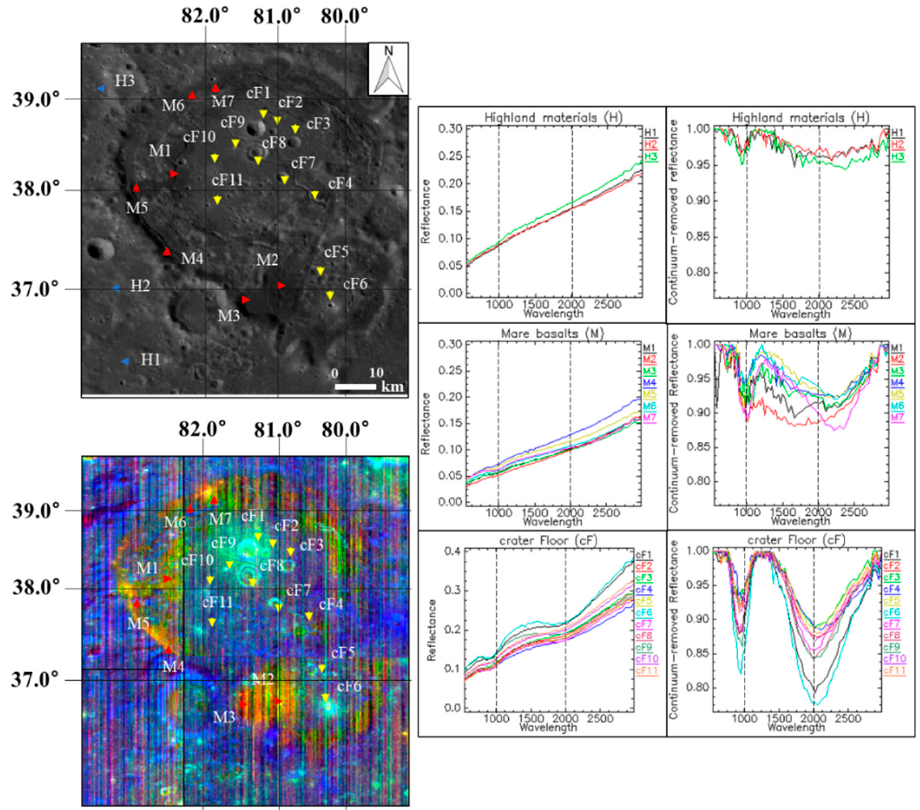
Figure 5. The WAC base map of the craters Lavoisier and Lavoisier F (Figure 4a) shows the locations in highland materials (H1–H3, blue arrows), mare basalts (M1–M7, red arrows), and on the crater floors (cF1–cF11, yellow arrows). To the right, the corresponding reflectance spectra and continuum-removed spectra are shown. On the lower left, the RGB composite derived from the M 3 level 2 data is shown. The dashed lines in the spectra indicate the wavelengths of 1000 nm and 2000 nm. The WAC base map was taken from https://quickmap.lroc.asu.edu, accessed on 1 April 2022. The location of each spectrum in Figure 5 to Figure 8 is provided in the Appendix C.